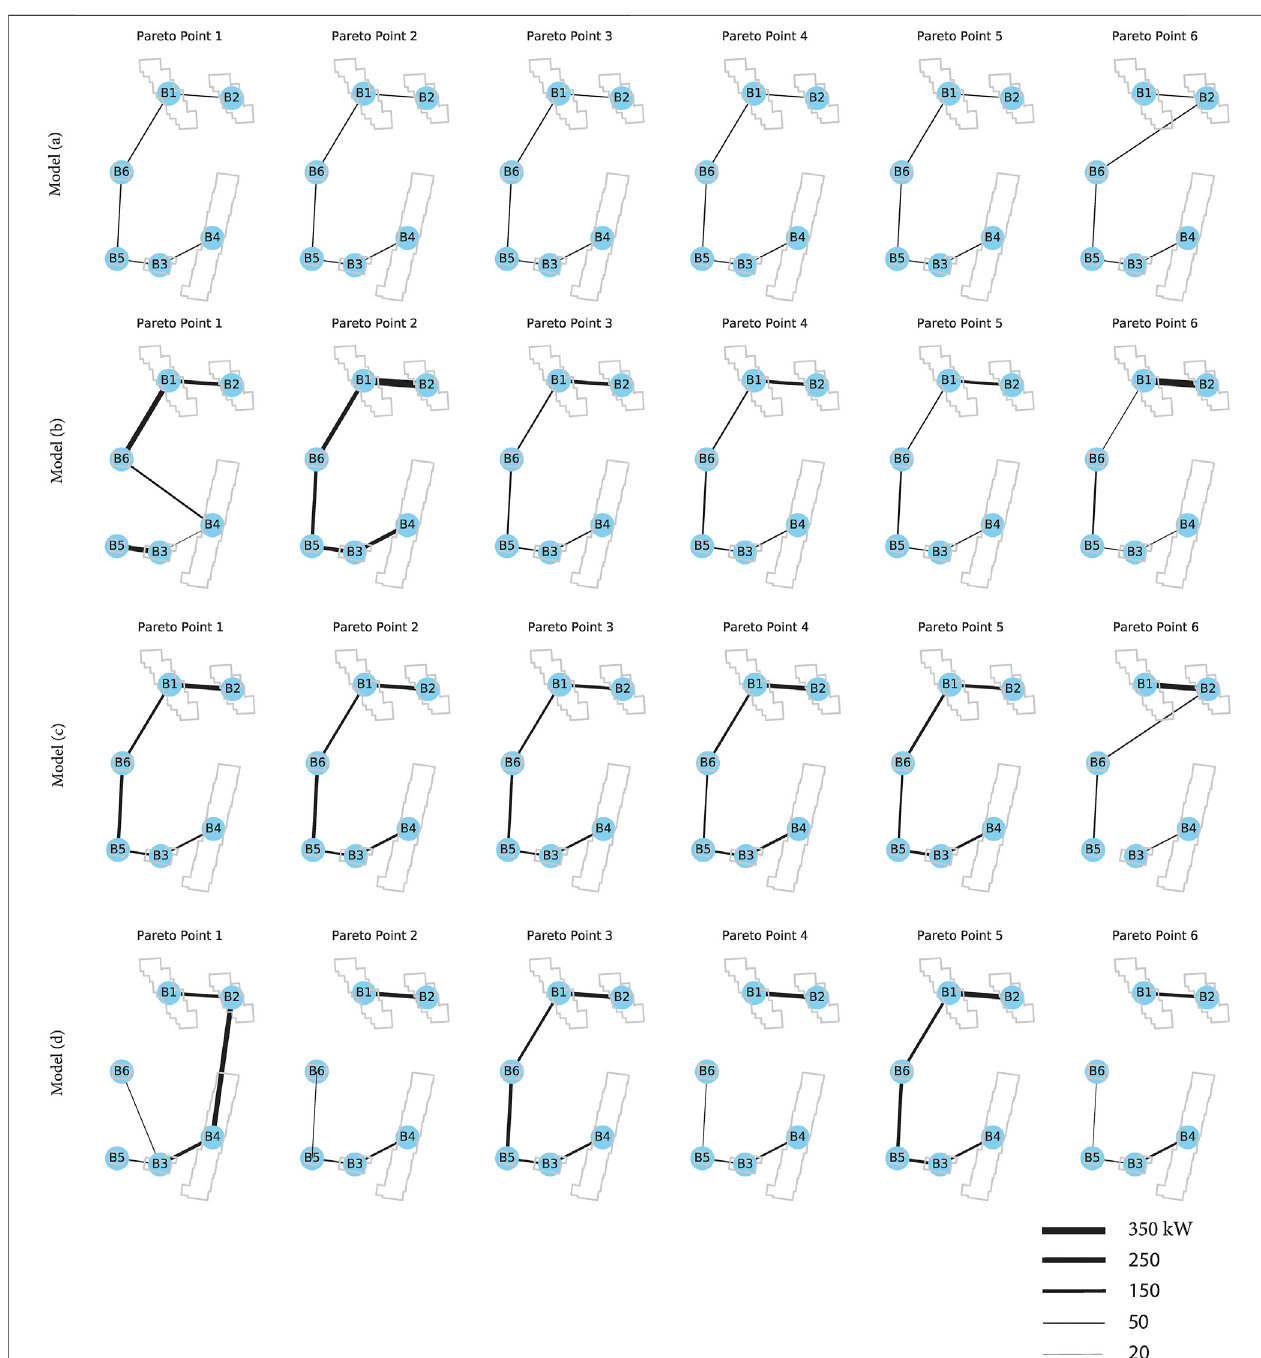
FIGURE 14 | Design capacities of storage technologies (TES and Battery) from the model (A) - (D) .